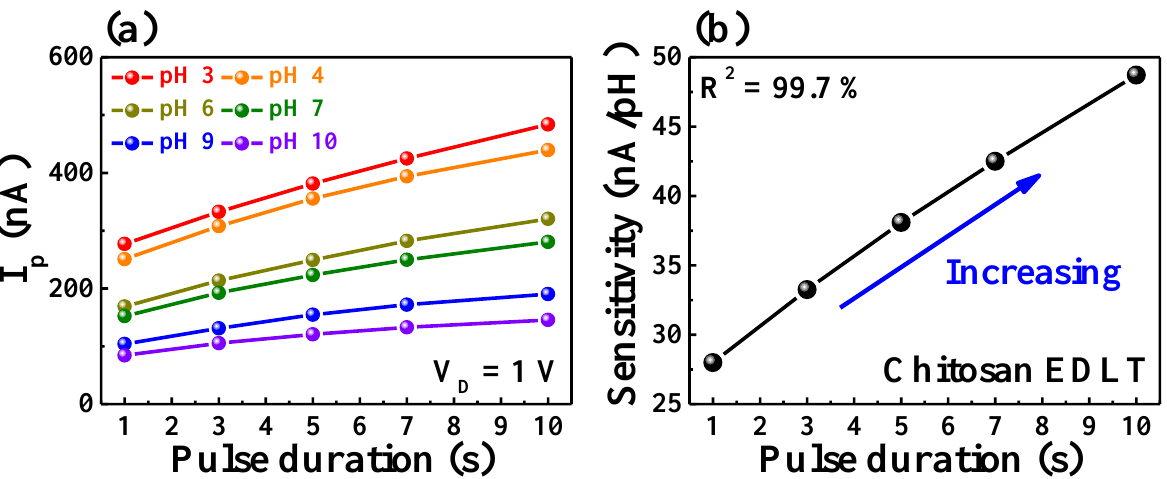
Figure 5. ( a ) Dynamic I D response in various pH buffer solutions; ( b ) pH-dependent changes in I D (I p − I p0 ) at a gate pulse (1s duration) of the chitosan/Ta 2 O 5 hybrid dielectric EDLT.